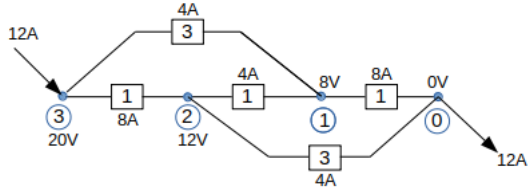
Figure 1. A simple resistor network, where nodes have potentials (measured in Volt) and edges have current (in Ampere) flowing through resistors with resistances in Ohm.